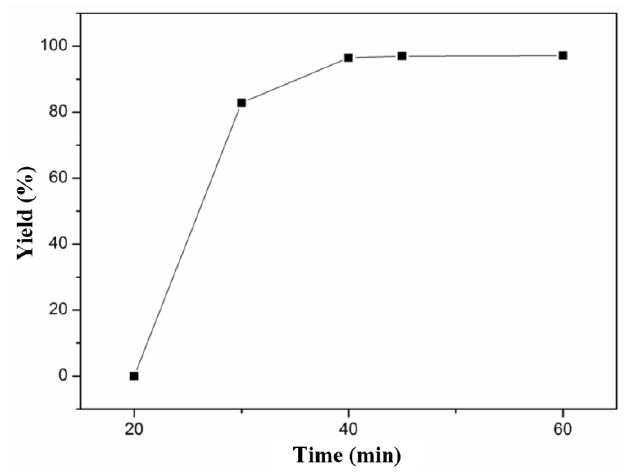
Figure 1. Effect of SCCO 2 copolymerization time on yield.